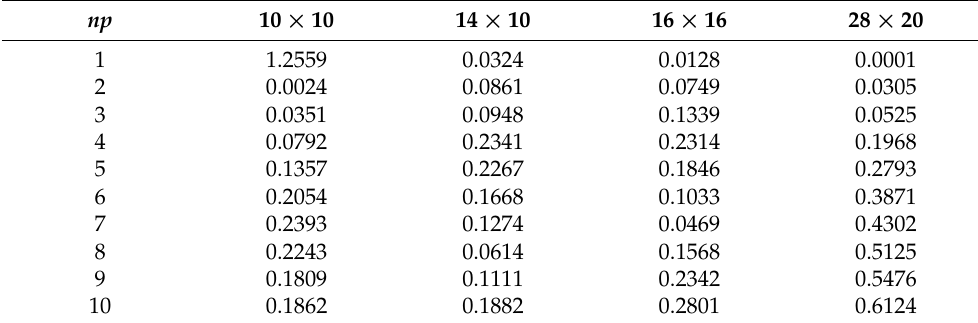
Table 1. Relative L 2 norm of the difference between the horizontal component of the velocity solution, u x , obtained with Legendre collocation with a mesh 50 × 50 in a single domain and the solution obtained with different numbers of subdomains on the horizontal axis, np , a single domain on the vertical axis, mp = 1, and different Legendre collocation meshes N × M ; R = 1300 and Γ = 3.495. np 10 × 10 14 × 10